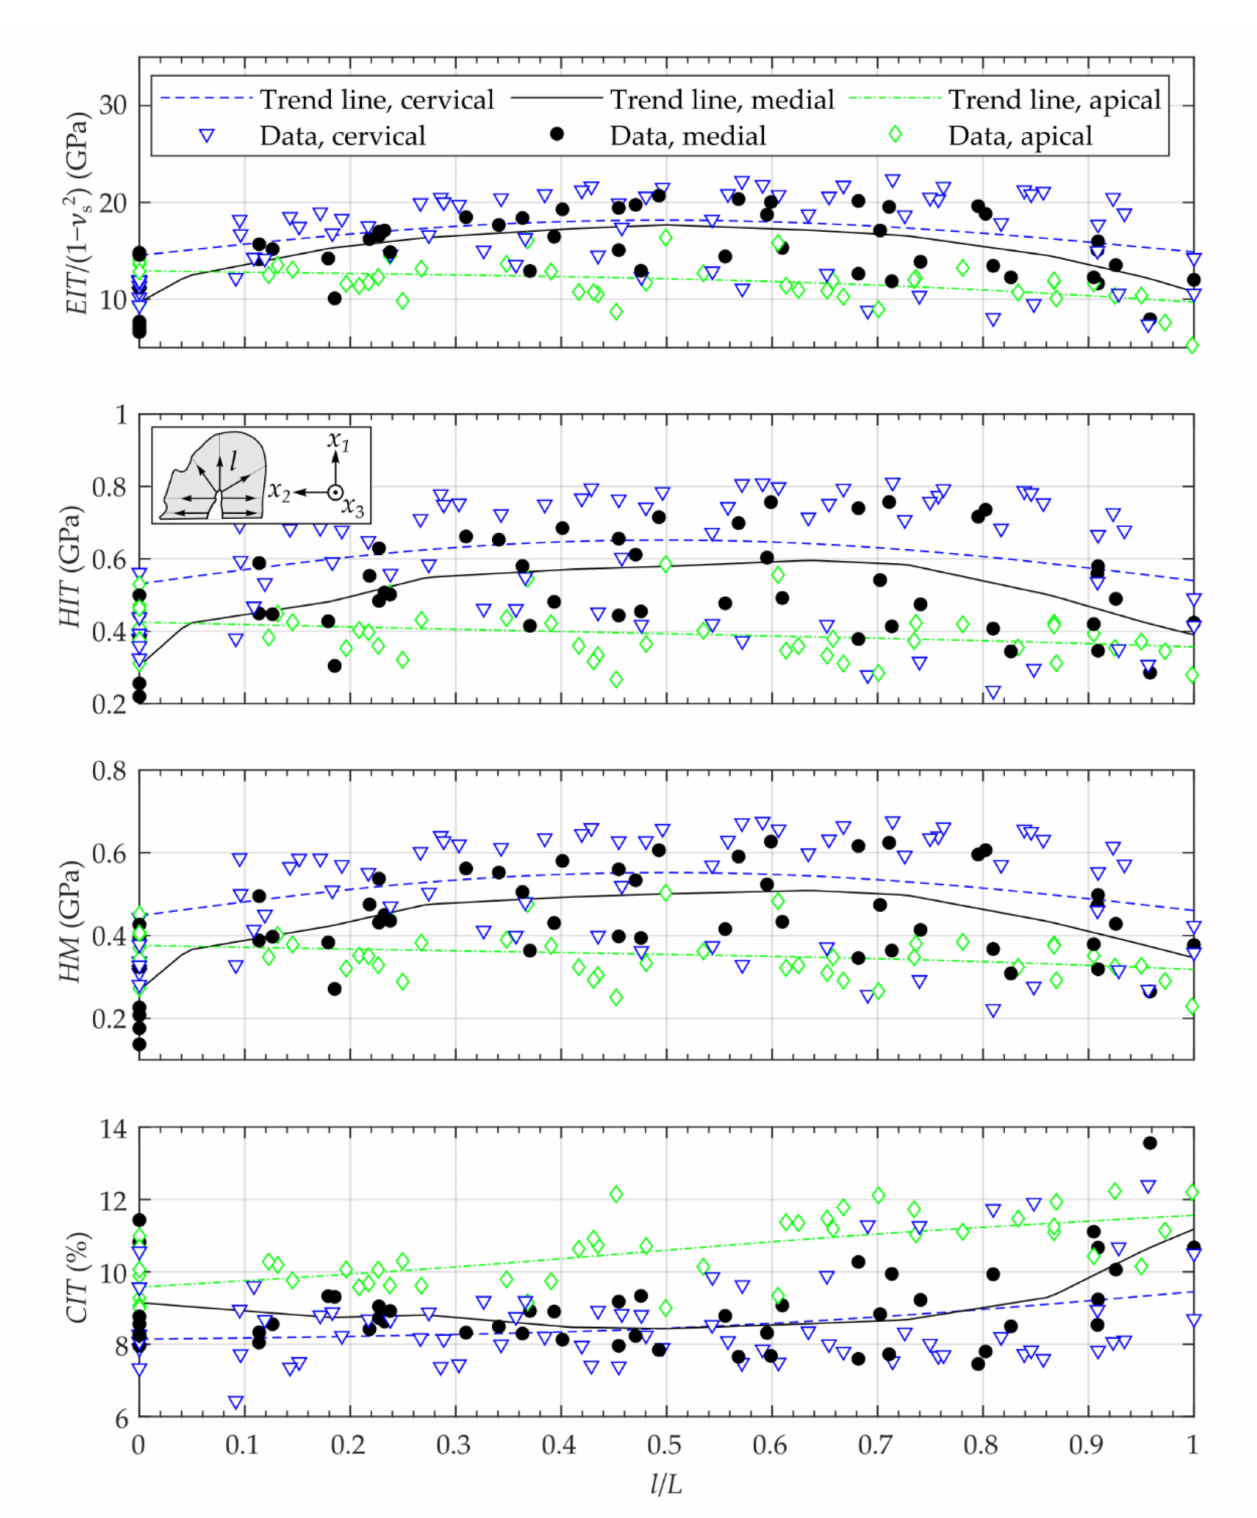
Figure 8. Micro-mechanical properties of the transversal segments evaluated at cutting lines (7